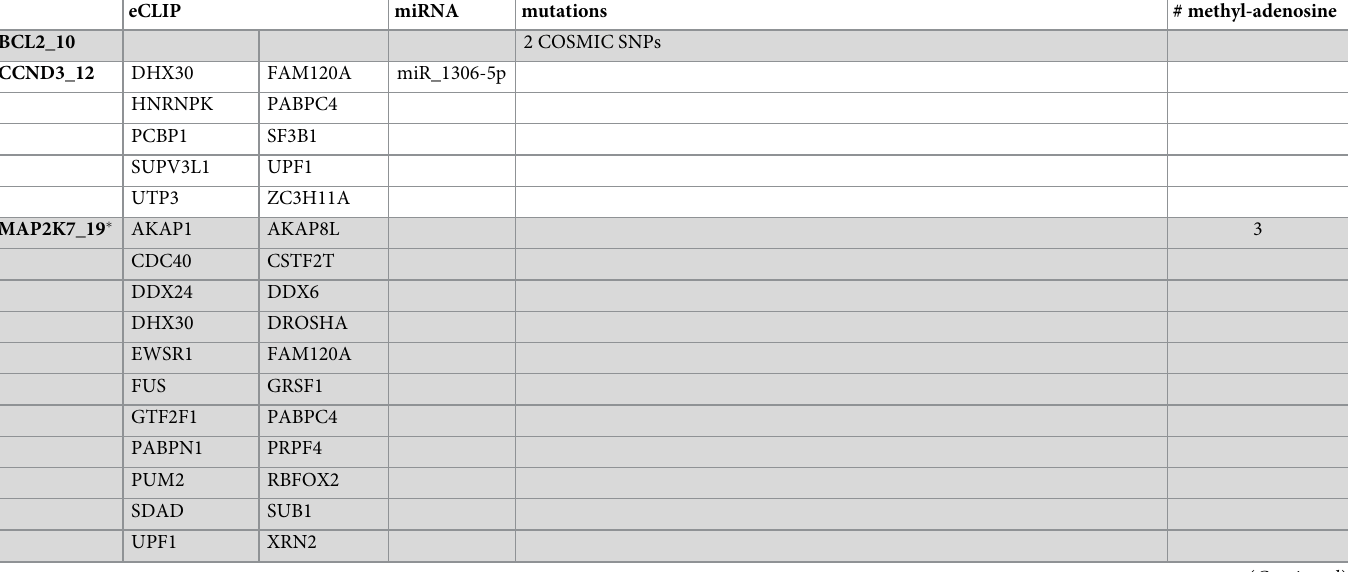
Table 2. Fig 7 structures with overlapping sequence features as indicated. eCLIP miRNA mutations # methyl-adenosine 2 COSMIC